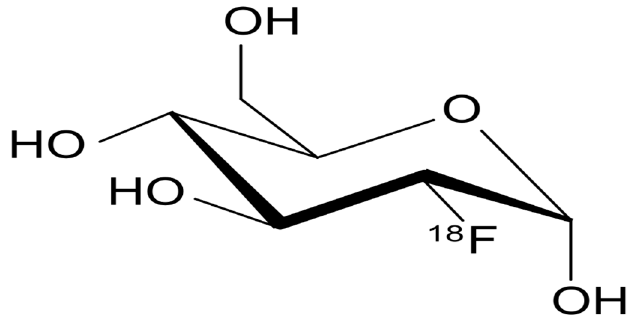
Figure 1. Chemical structure of 2-[ 18 F]FDG.